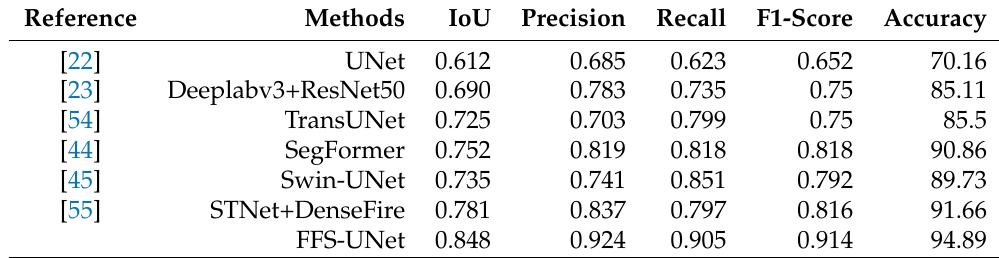
Figure 11. Qualitative comparison of fire segmentation results on the Corsican Fire dataset [56]. From left: ( a ) Fire image, ( b ) corresponding ground-truth mask, and predicted masks by ( c ) Swin- UNet, ( d ) TransUNet, ( e ) SegFormer, ( f ) STNet+DenseFirand ( g ) Deeplabv3+ResNet50 ( h ) UNet, and ( i ) FFS-UNet. Table 7. Fire detection results, as compared to different methods, on the Corsican Fire dataset